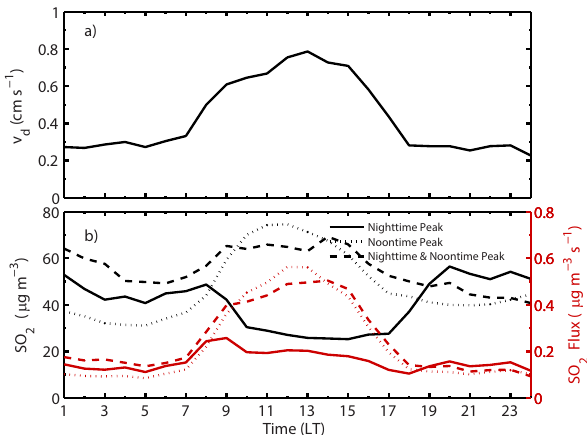
Figure 6. (a) Diurnal variation of the dry deposition velocity in- ferred from Tsai et al. (2010); (b) Calculated dry deposition fluxes (red lines) based on the three characteristic SO 2 diurnal variation patterns (black lines) in Wuqing during autumn